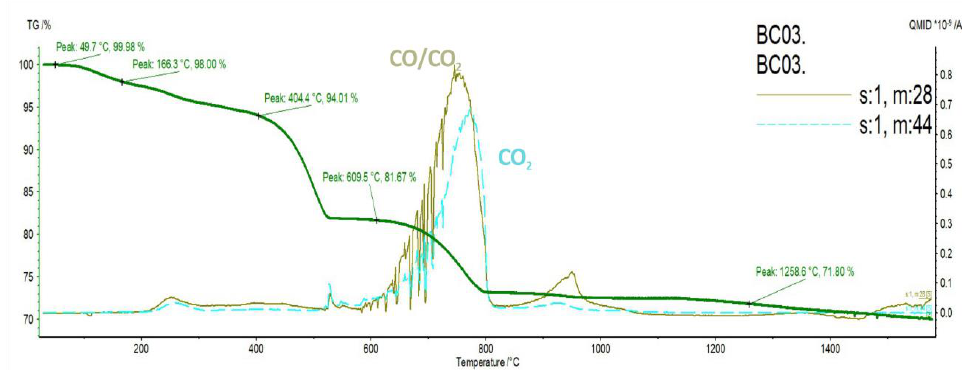
Figure 8. BC03 TGA-MS diagram.